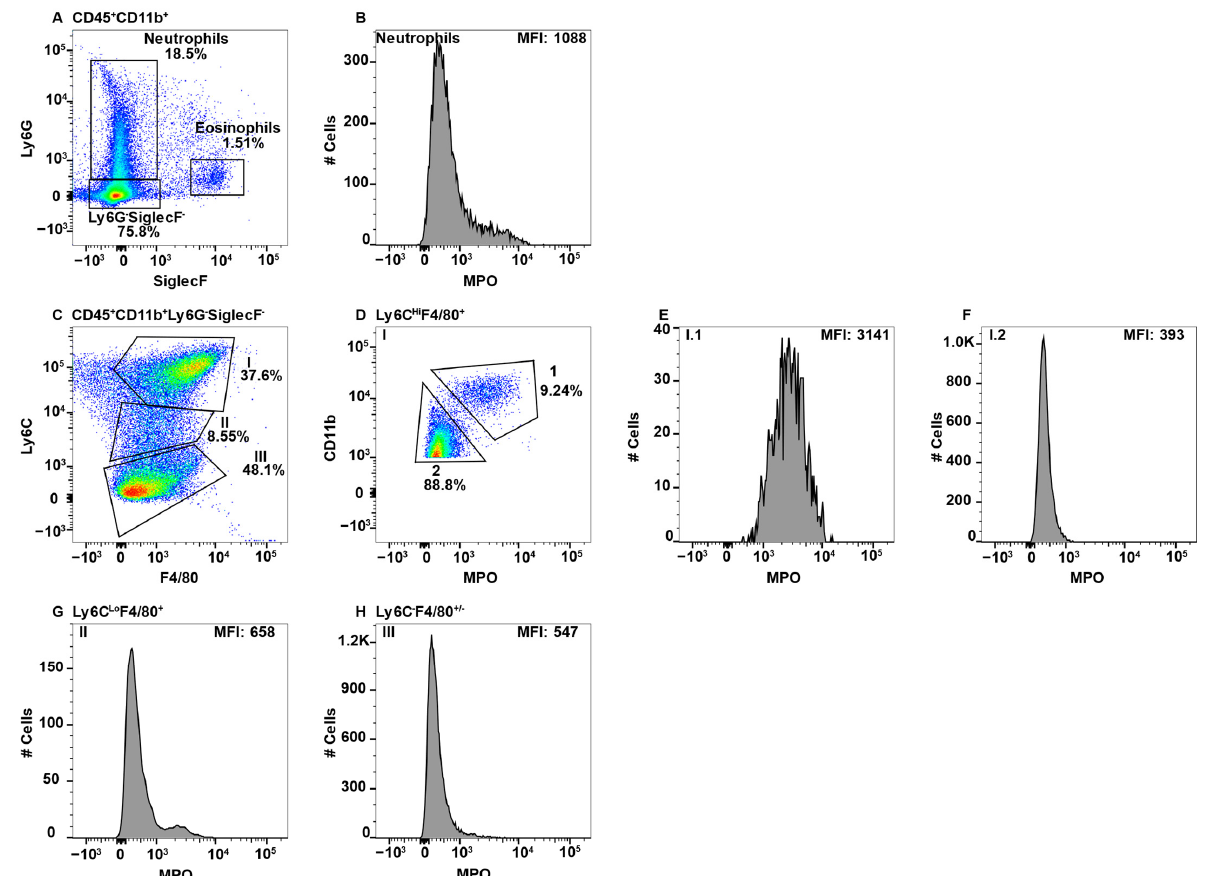
Figure 7. MLN macrophage subsets differentially express MPO. MLN cells were stained with antibodies that were specific for CD45, CD11b, Ly6C, Ly6G, F4/80, MPO, and SiglecF and using flow cytometry CD45 + CD11b + cells were analyzed for Ly6G and SiglecF expression to identify Ly6G + SiglecF − neutrophils and Ly6G − SiglecF + eosinophils ( A ). Neutrophil expression of MPO is shown ( B ). CD45 + CD11b − Ly6G − SiglecF − cells were analyzed for F4/80 and Ly6C expression and three Subpop (III) were identified ( C ). Subpop I F4/80 + Ly6C Hi cells were separated into CD11b Hi (1) and CD11b Lo (2) populations ( D ), and MPO expression is shown ( E and F , respectively). MPO expression in Subpop II Ly6C Lo F4/80 + ( G ) and III Ly6C − F4/80 − ( H ) is shown. The percent positive cells in dot plot gates and the MFI of histograms is provided. Data shown are representative of three